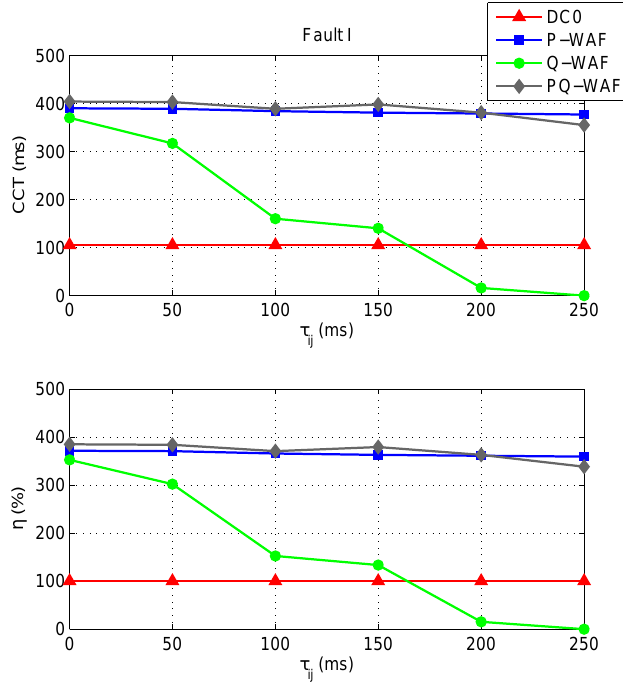
Figure 25. Case A. CCTs and η versus communication